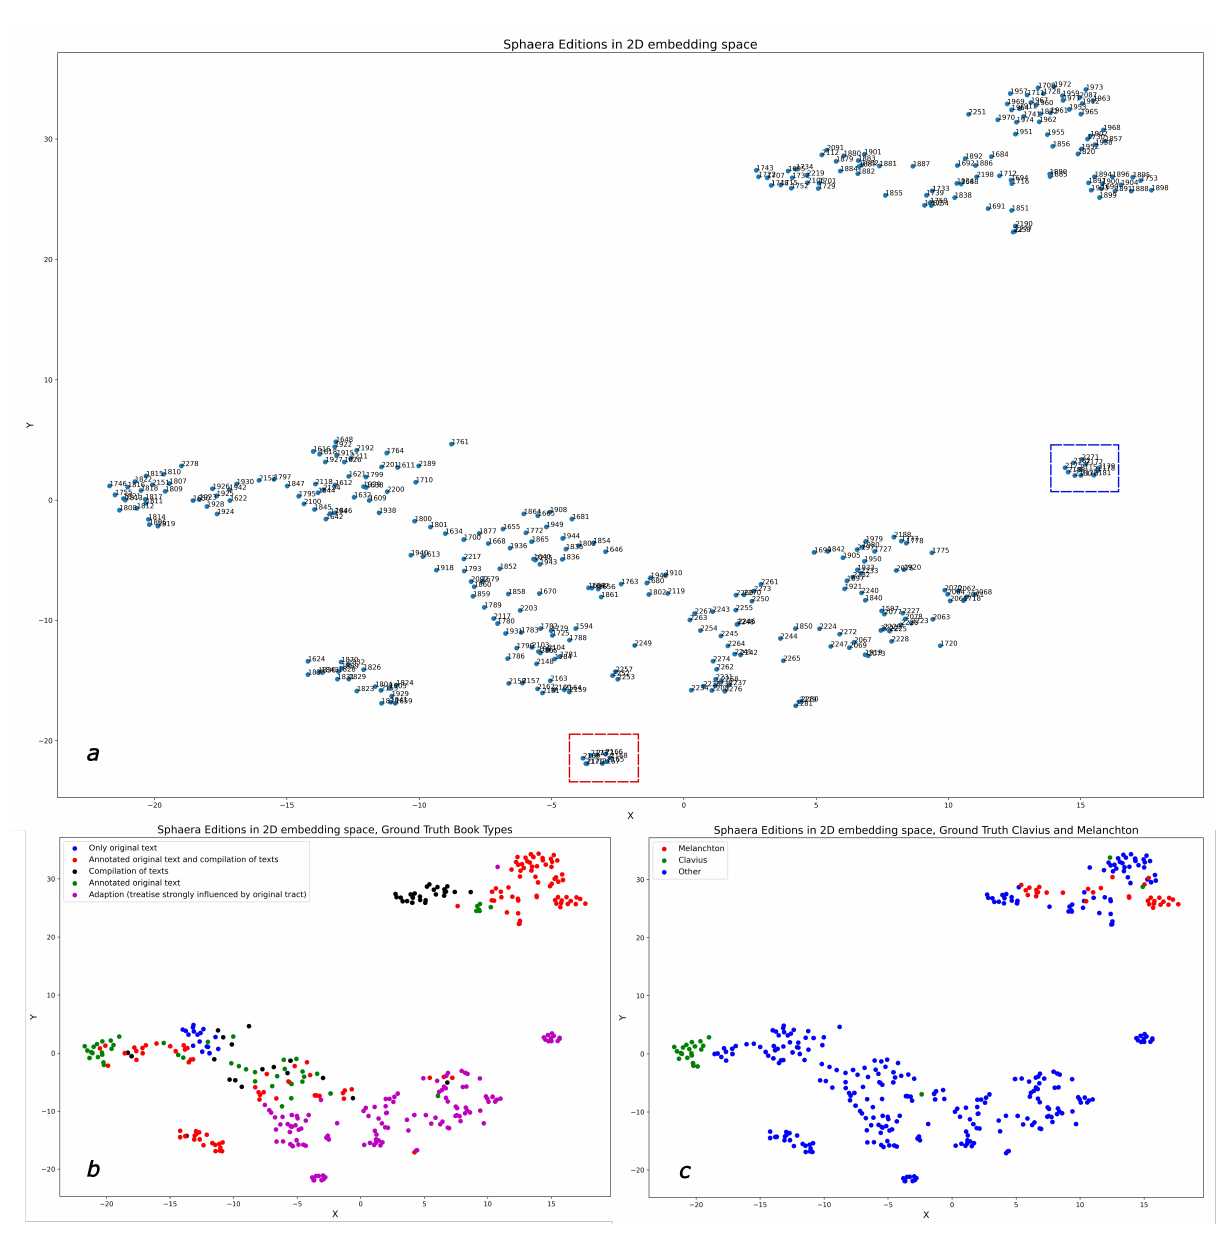
Figure 6. ( a ): t-SNE representation of all 359 book edition entities in the Sphaera dataset; ( b ): ground truth data-based book types; ( c ): ground truth data based on books containing texts by specific